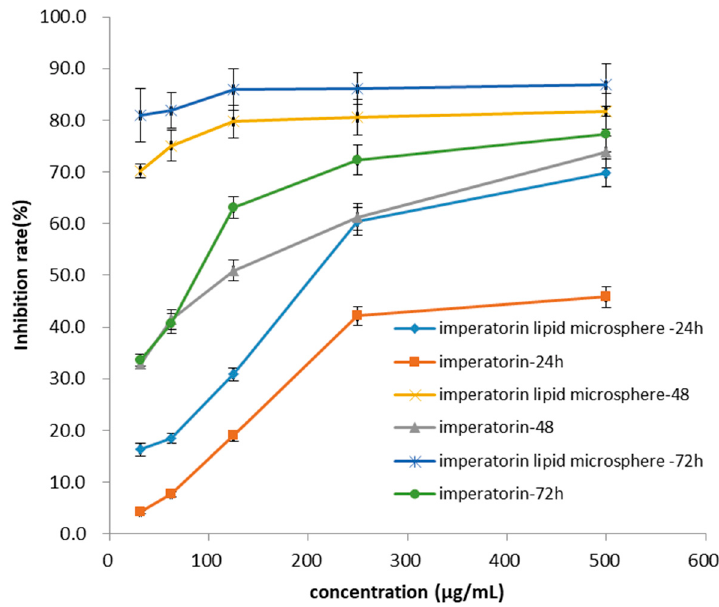
Figure 4. Inhibition cures of imperatorin and imperatorin lipid microspheres against MDA-MB-231.